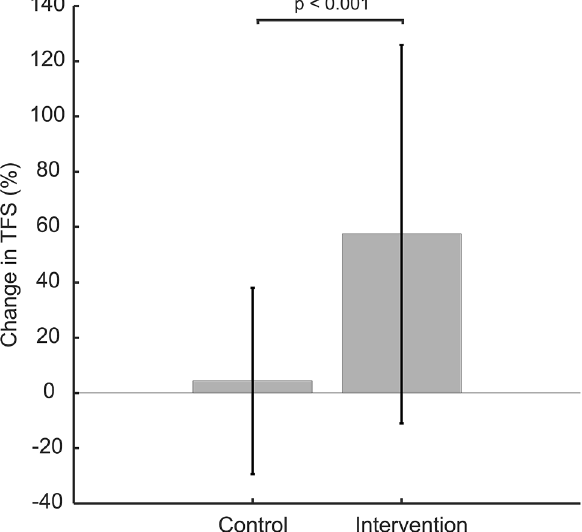
Figure 3. Percent change in “Toe flexion strength” (TFS, Eq. 2) at the end of the intervention study compared to the